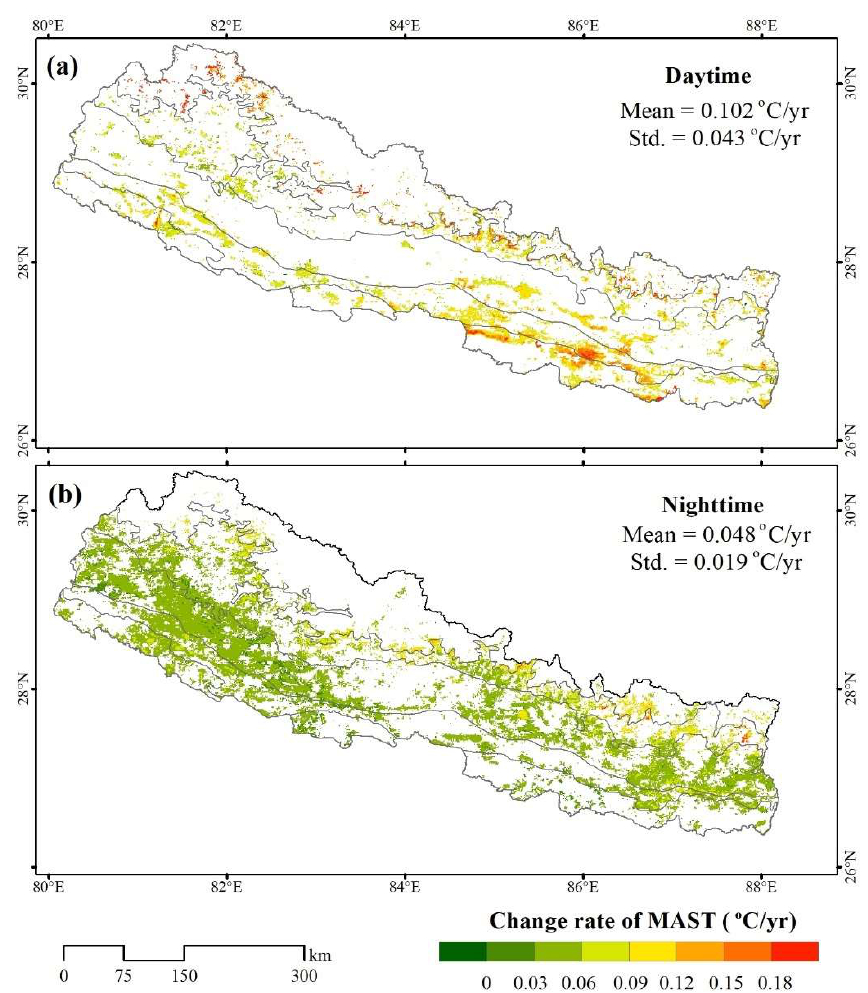
Figure 6. Change rates in significant changing areas of the ( a ) daytime MAST and ( b ) nighttime MAST during the period from 2000 to 2017.